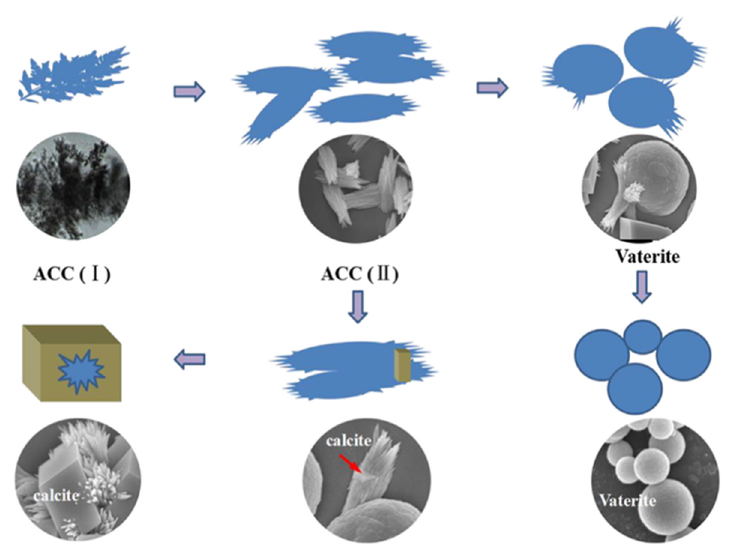
Figure 3. Schematic image of the crystallization pathway of amorphous and crystalline CaCO 3 and corresponding SEM images. Image reproduced from Youpeng Zeng et al., with permission from Cryst. Growth Des. [36].